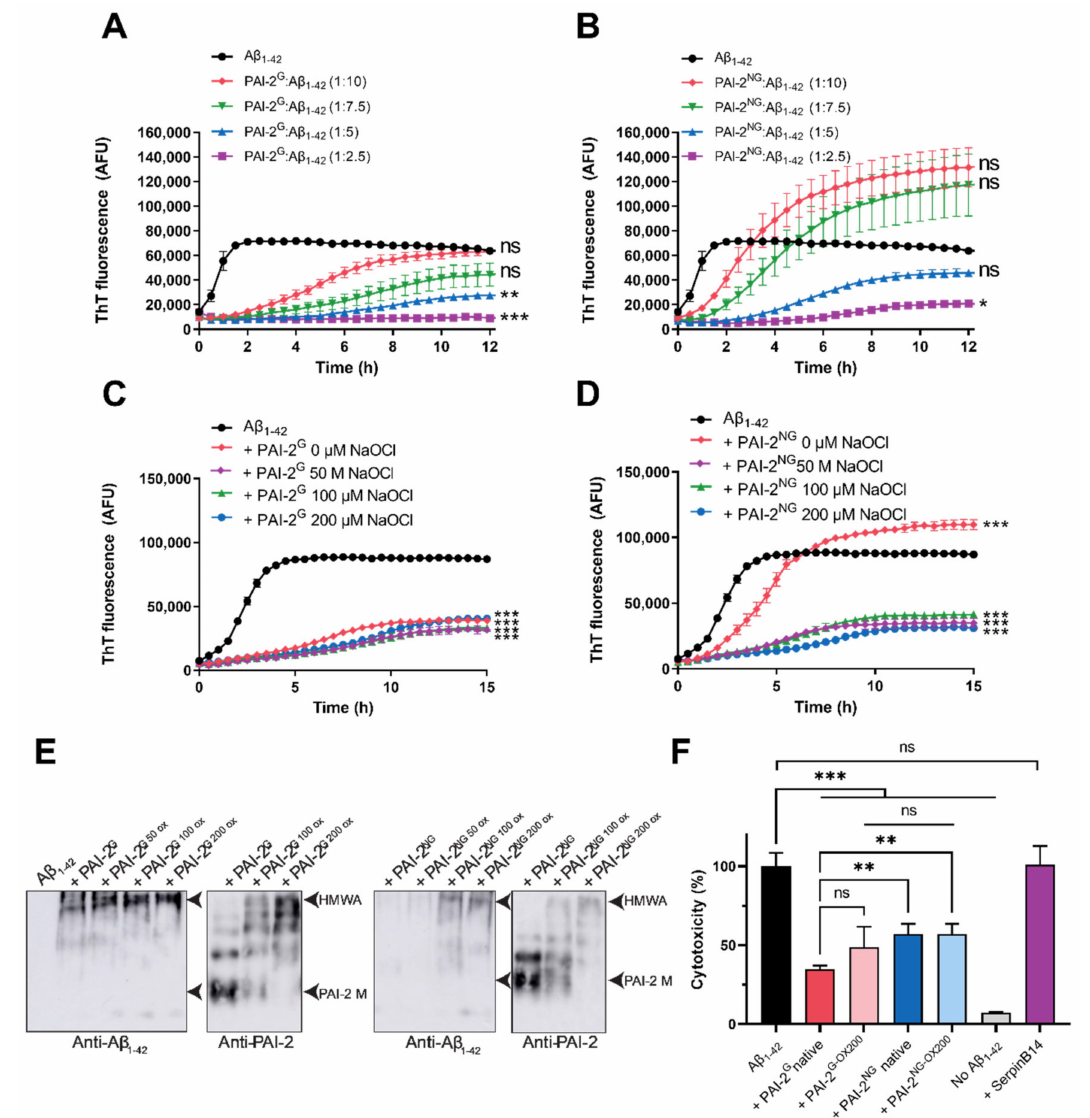
Figure 3. The effect of native or hypochlorite-treated PAI-2 G and PAI-2 NG on the aggregation and cytotoxicity of A β 1–42 . ( A , B ) A β 1–42 (3 µ M) was incubated with 25 µ M ThT in PBS at 28 ◦ C ± ( A ) PAI- 2 G or ( B ) PAI-2 NG at the molar ratios indicated (1:2.5–10 PAI-2:A β 1–42 ). ( C , D ) A β 1–42 was